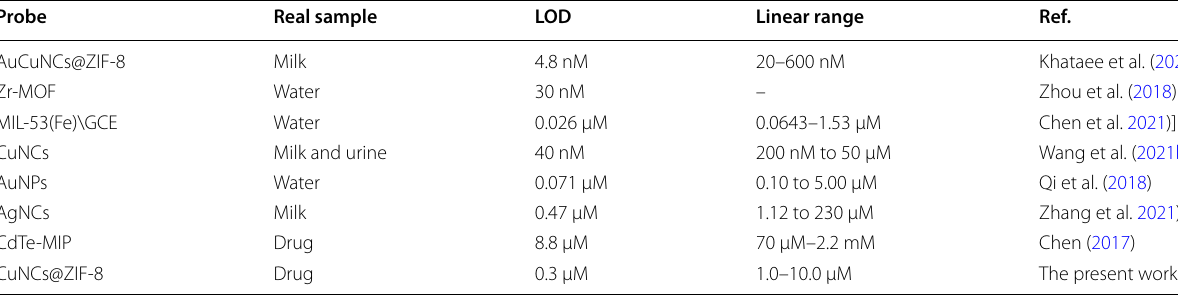
Table 2 Comparison of different fluorescent methods for TC sensing